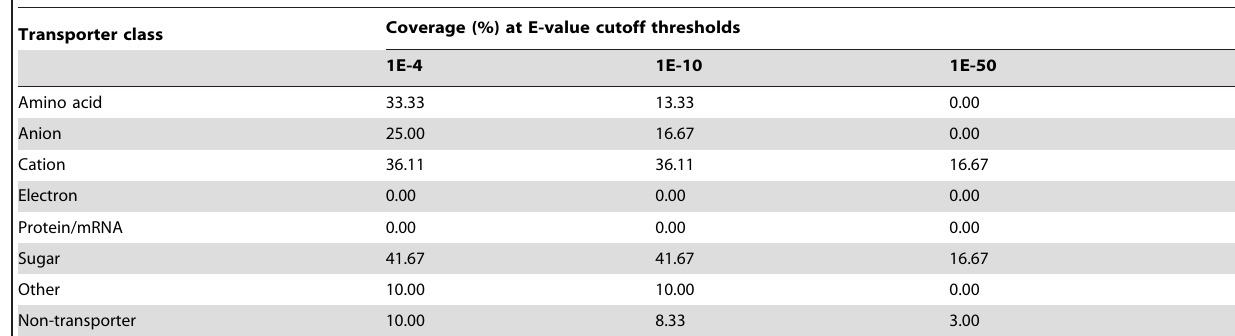
Table 7. The performance (coverage metric) of the BLAST search on the independent dataset.